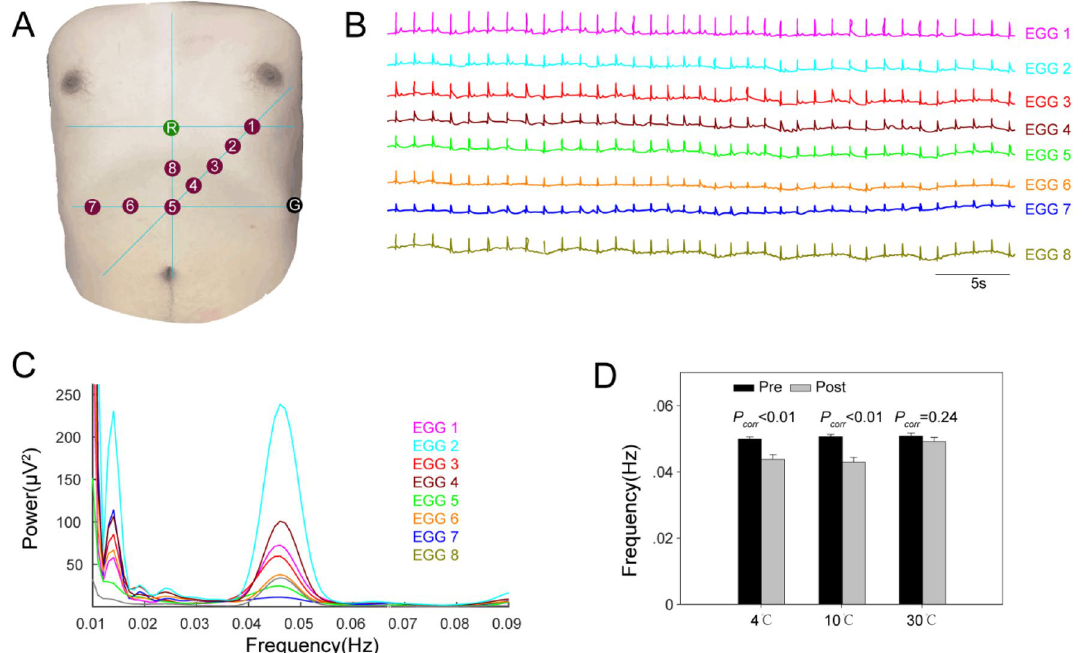
Figure 2. EGG power spectra changes. ( A ) Cutaneous electrode position; ( B ) raw data of EGG; ( C ) power spectra of EGG; ( D ) EGG peak frequency before and after stimulation. P corr < 0.01 (4 °C); P corr < 0.01 (10 °C); P corr = 0.24 (30 °C); P corr : corrected P value. EGG,